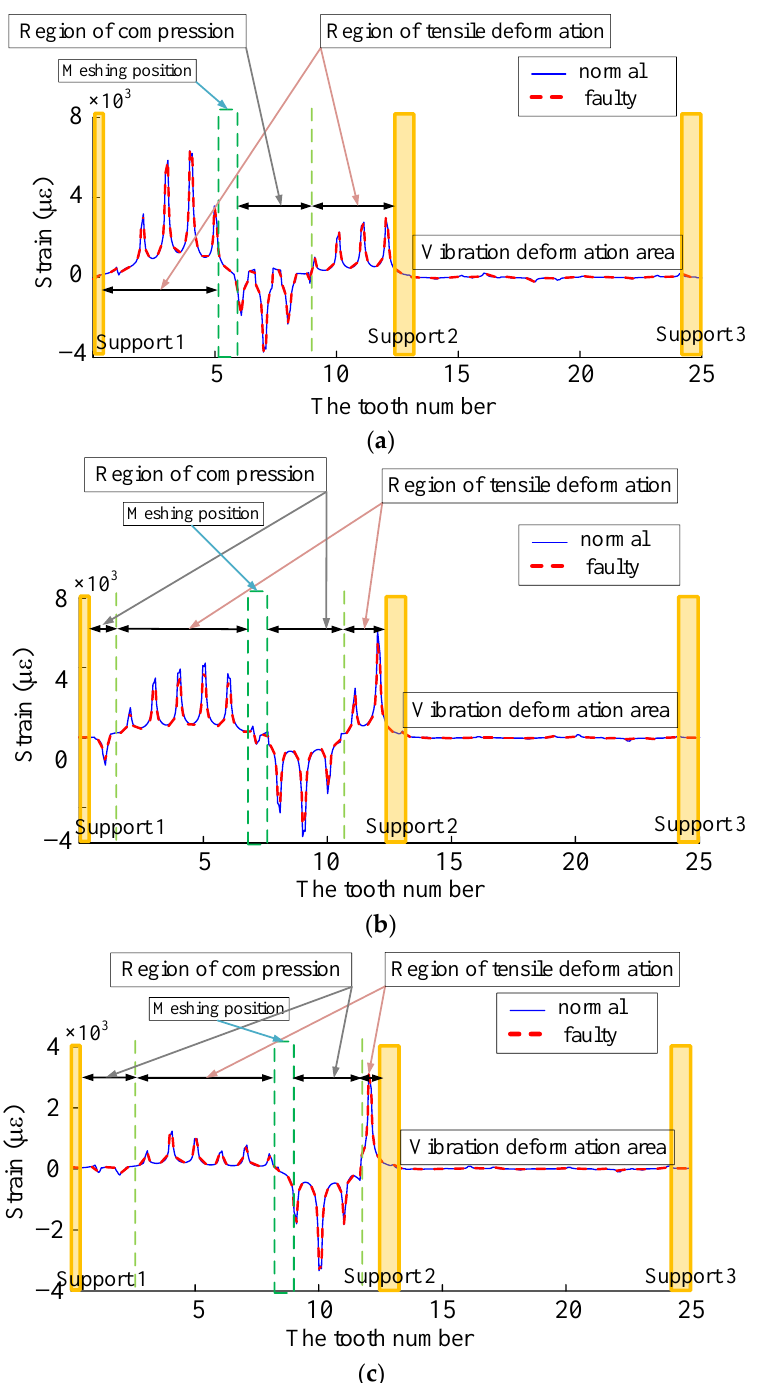
Figure 16. ( a ) The stress fluctuation curve of the fault tooth is about to be inserted. ( b ) Strain fluctuation curve of the snagging fault tooth. ( c ) Strain fluctuation curve of the gnawed fault tooth.